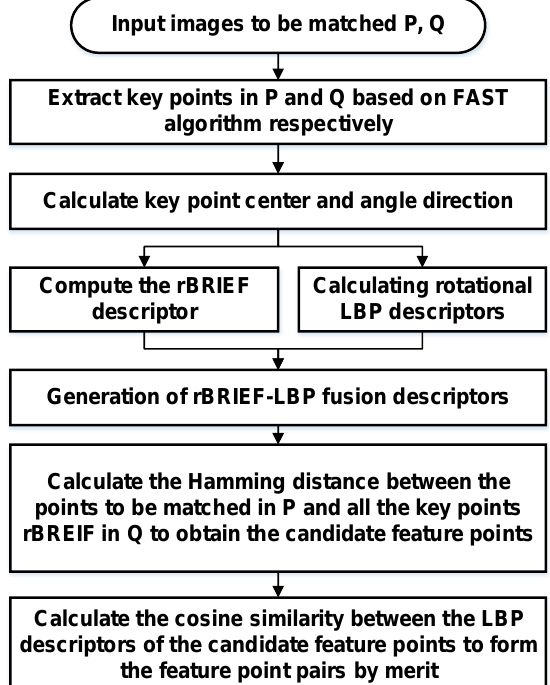
Figure 1. Feature point matching